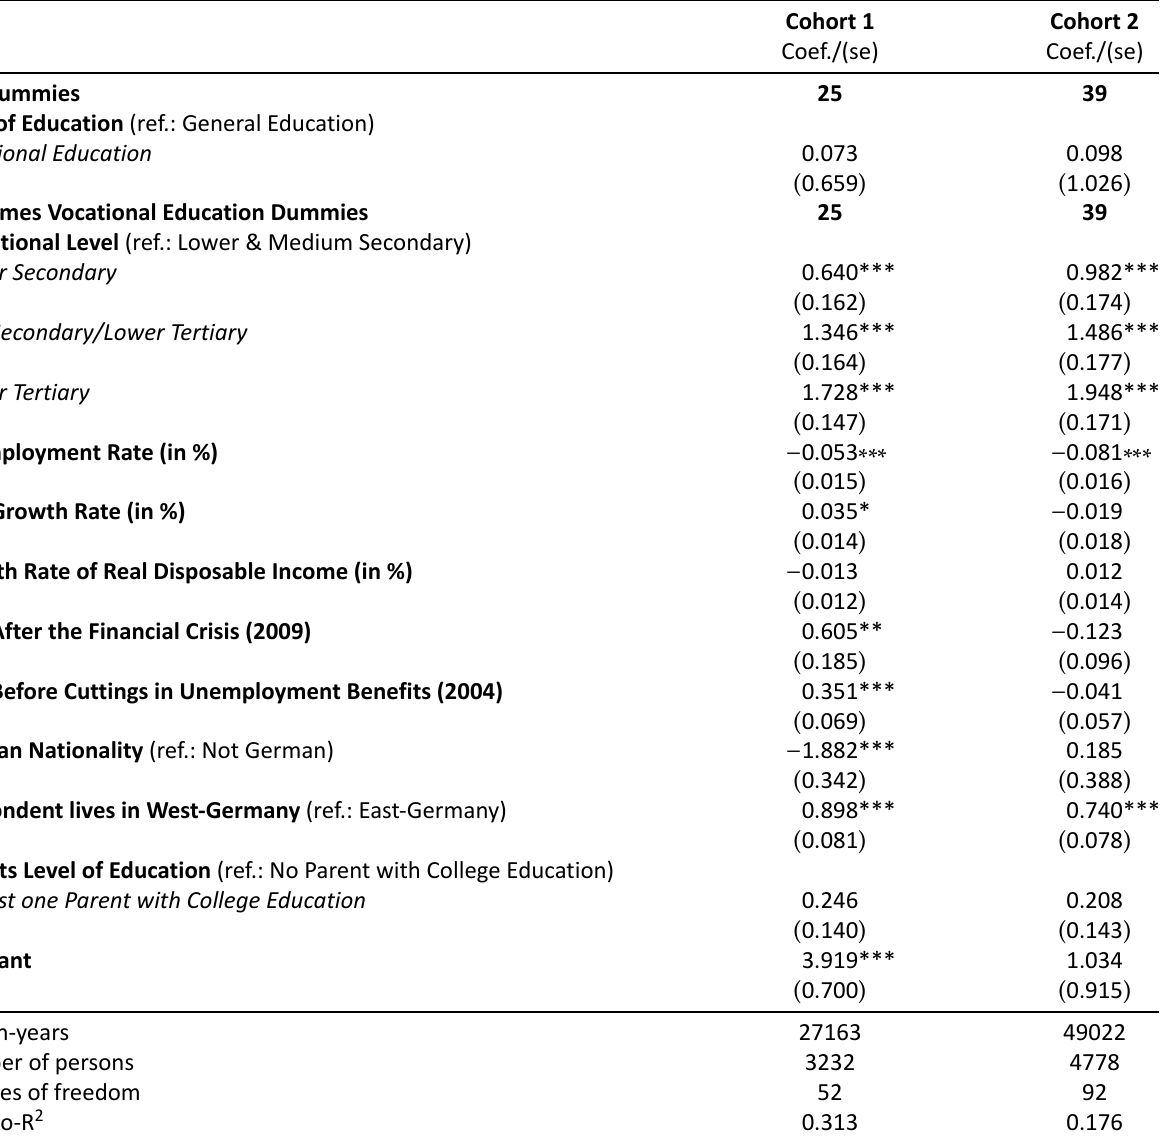
Table A7. Employment opportunity over the life course: General versus vocational education by cohort (men). Data source: GSOEP